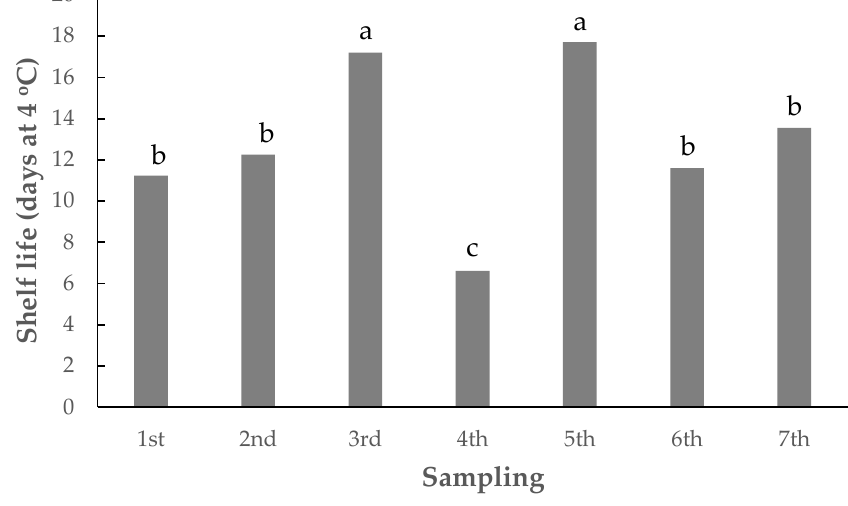
Figure 5. Shelf life of baby rocket leaf stored at 4 °C, as affected by growing season. Columns with different letters are significantly different (a < 0.05).